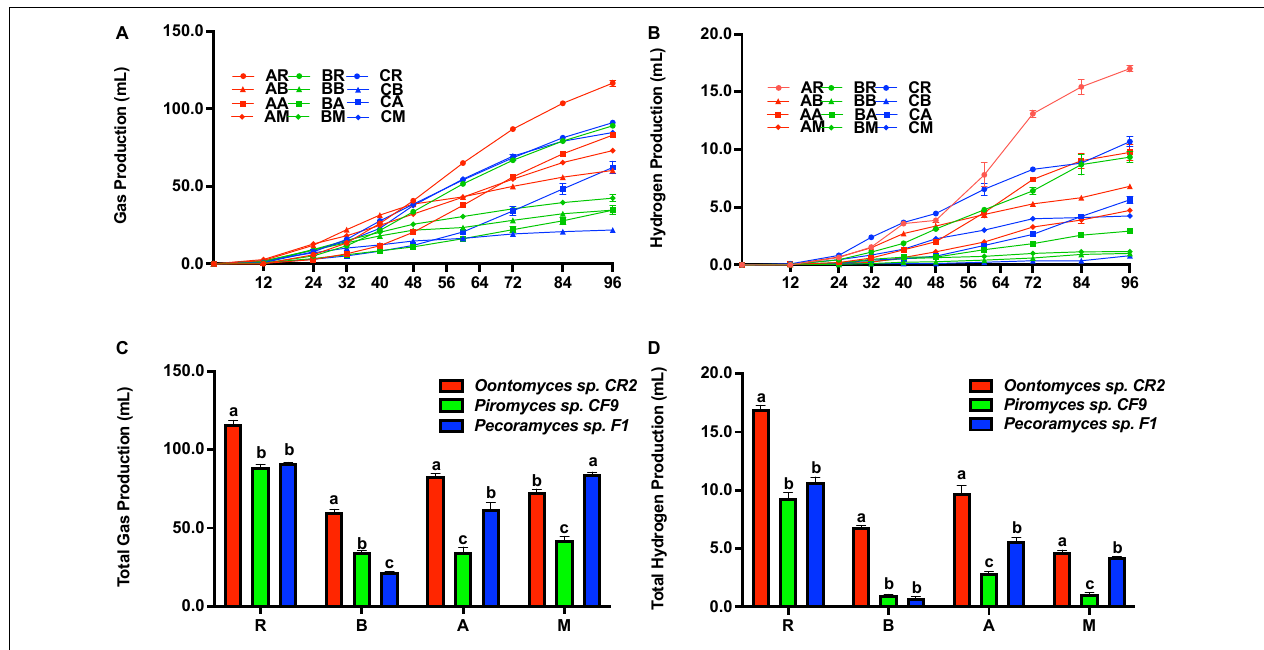
FIGURE 3 | Cumulative gas and H 2 production (A,B) , and total gas and H 2 production (C,D) after 96 h fermentation with Oontomyces sp. CR2, Piromyces sp. CF9, and Pecoramyces sp. F1 using different substrates (R, Reed; B, Broussonetia papyrifera leaves; A, Alfalfa stalk; M, Melilotus officinalis ). The error bars represent the standard error of the mean ( n = 4), and means with different letters in the same column are different at P <